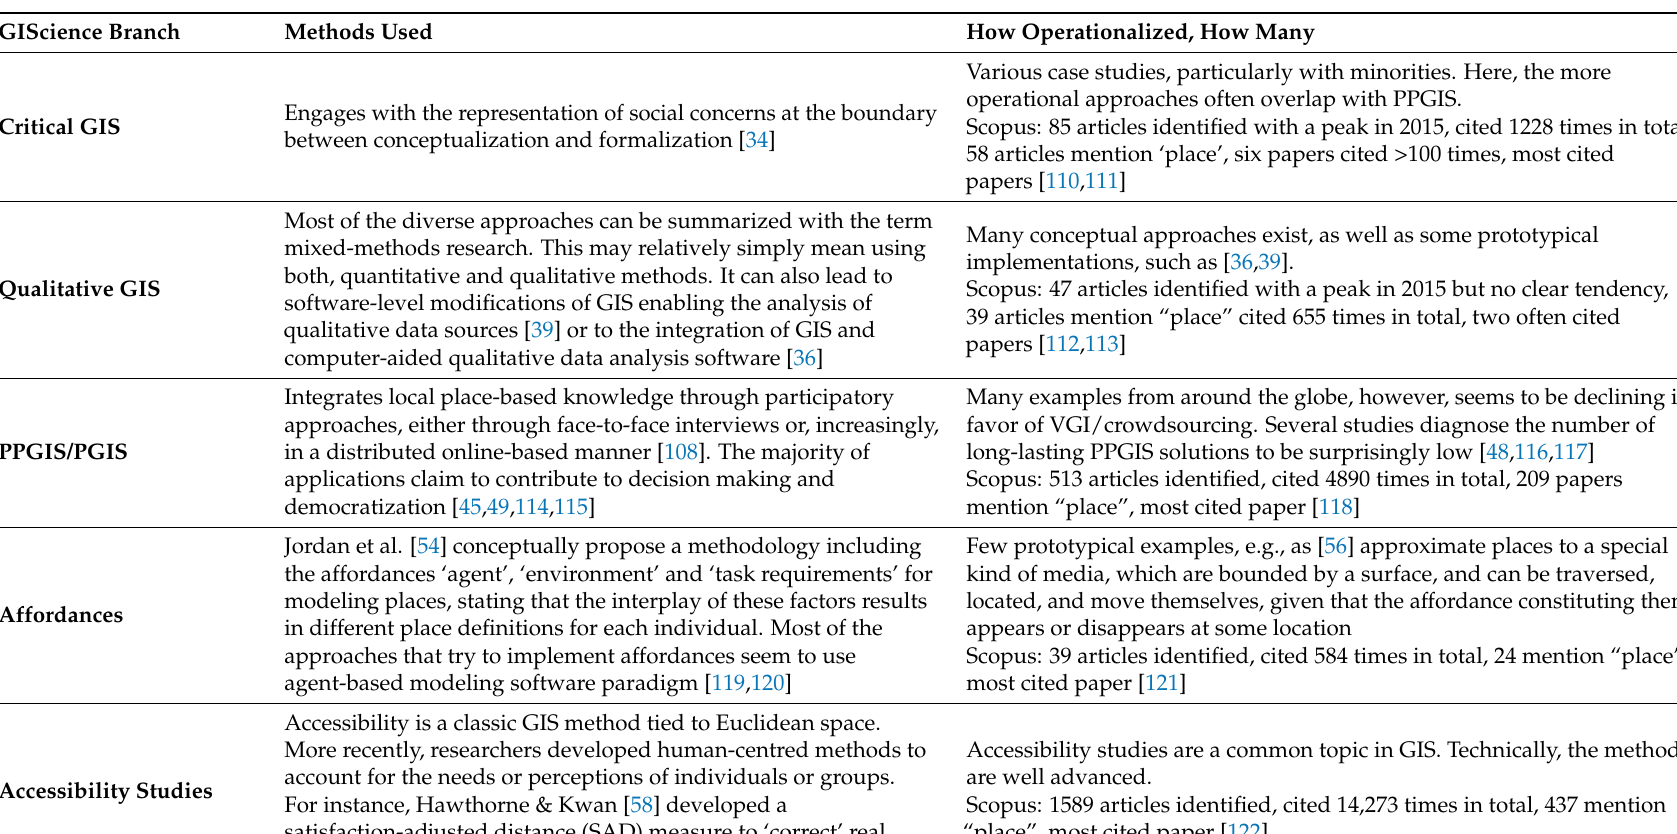
Table 1. Branches of GIScience research concerned with place, and their respective